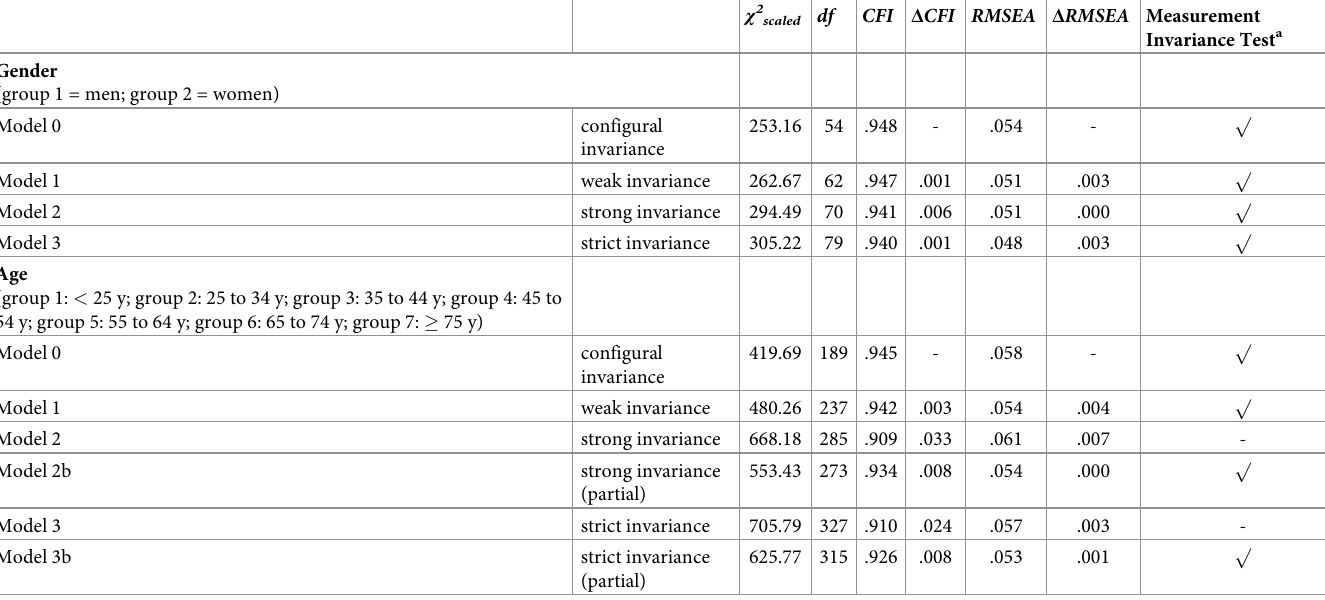
Table 4. Analysis of factorial invariance for age and gender using multi-group confirmatory factor